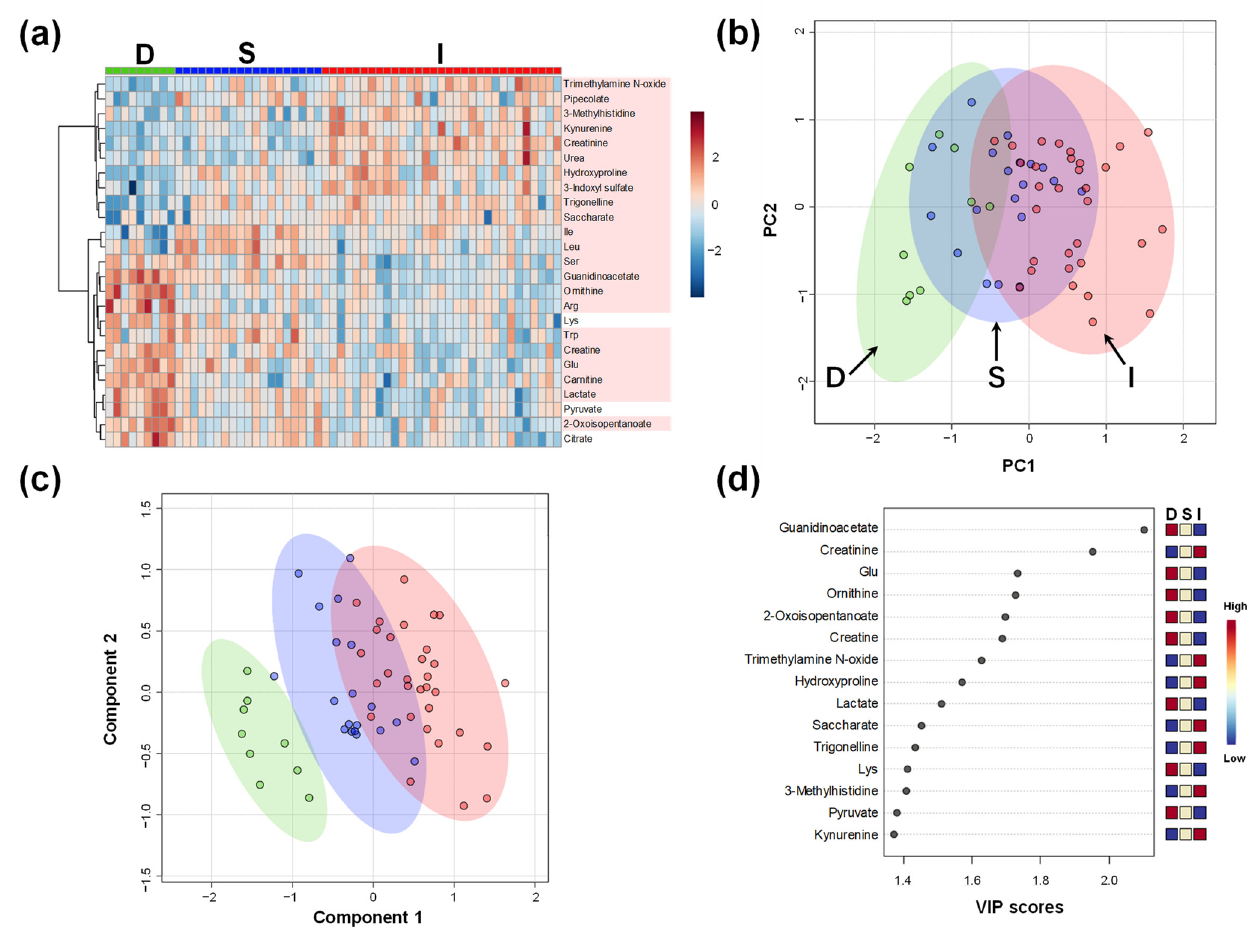
Figure 1. Overall metabolomic plasma profile of all participants in D, S, and I Groups. ( a ) Heatmap to visualize the metabolomic profile. Absolute concentrations are divided by the median value of each sample, log 2 -transformed, and converted to Z-score. Metabolites showing high variation among the three groups (top 25 by analysis of variance) are visualized. The metabolites showing p < 0.05 (ANOVA) are colored; ( b ) Score plots of principal component (PC) analysis. The contribution ratios are 20.2% and 12.7% for the first and second PC (PC1 and PC2), respectively. Green, blue, and red dots indicate data in D,S, and I Groups. The corresponding ellipses show 95% confidence intervals; ( c ) Score plots of partial least squares-discriminant analysis (PLS-DA). R 2 and Q 2 of leave-one-out-cross-validation are 0.82 and 0.70, respectively. The dots and ellipses are the same as the ones in the panel (c); ( d ) Variable importance of projection (VIP) scores of PLS-DA. D, Donor group; S, kidney transplant recipients with stable kidney function; I, kidney transplant recipients with impaired kidney function.